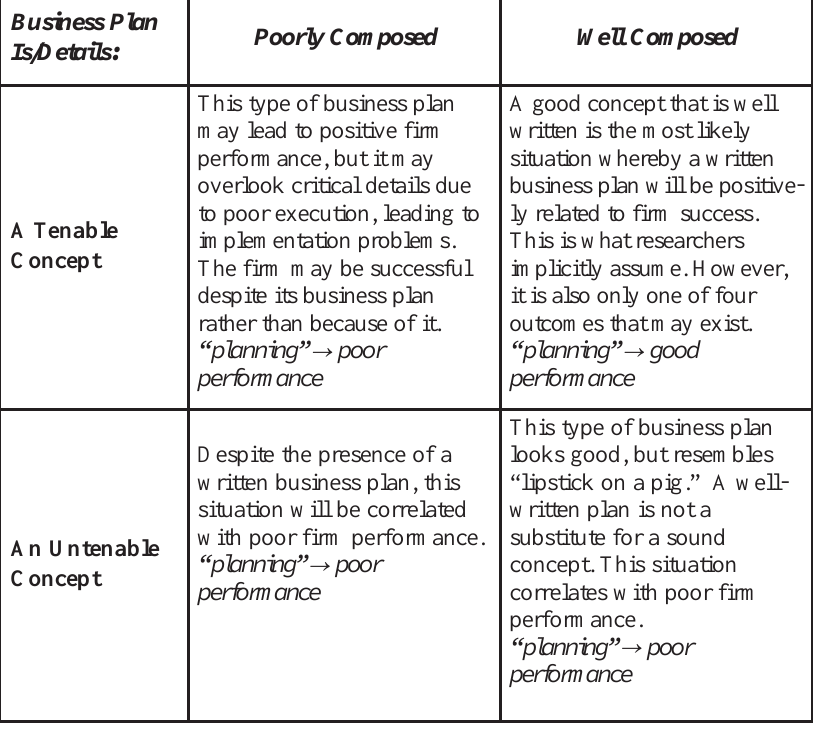
Figure 1. Omitted Variable